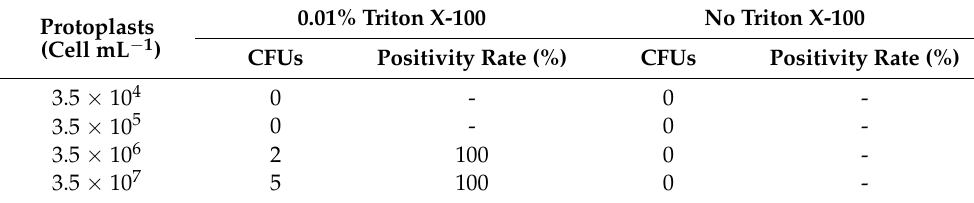
Table 3. Effect of protoplast concentration on targeting efficiency.